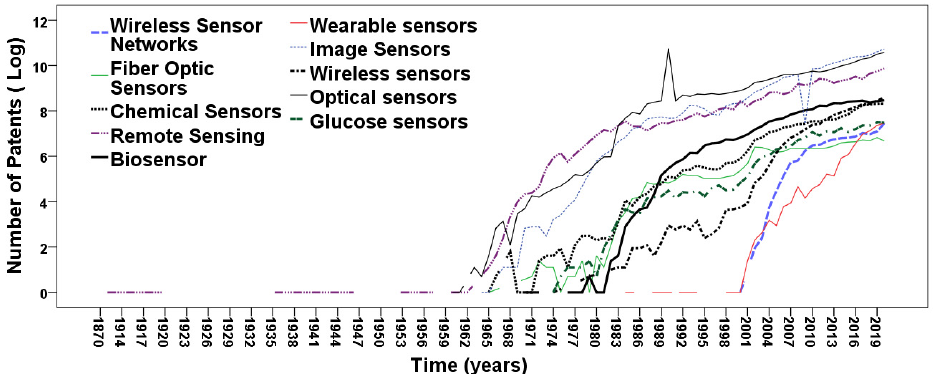
Figure 3. Technological trajectories of sensor using patents ( log scale).